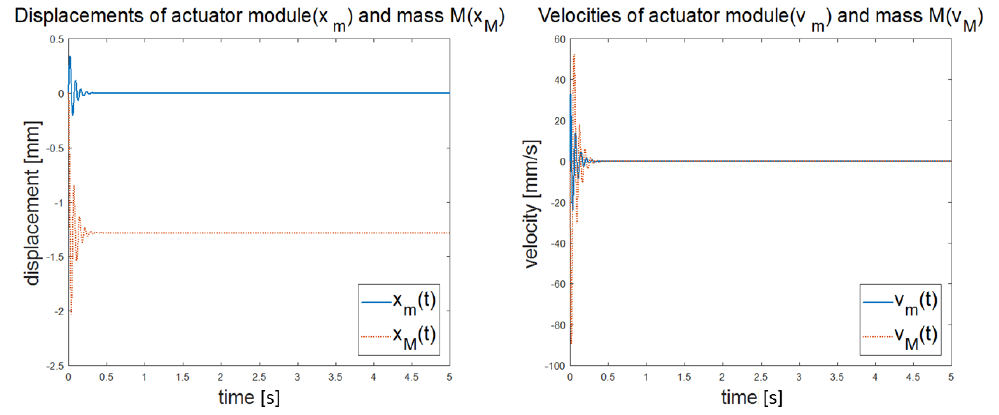
Figure 11. Displacement ( x m , x M ) and velocity ( v m , v M ) plots of the HSAM and the wire-attached mass M under Ω = 160 rev/s and M = 102.5 g.